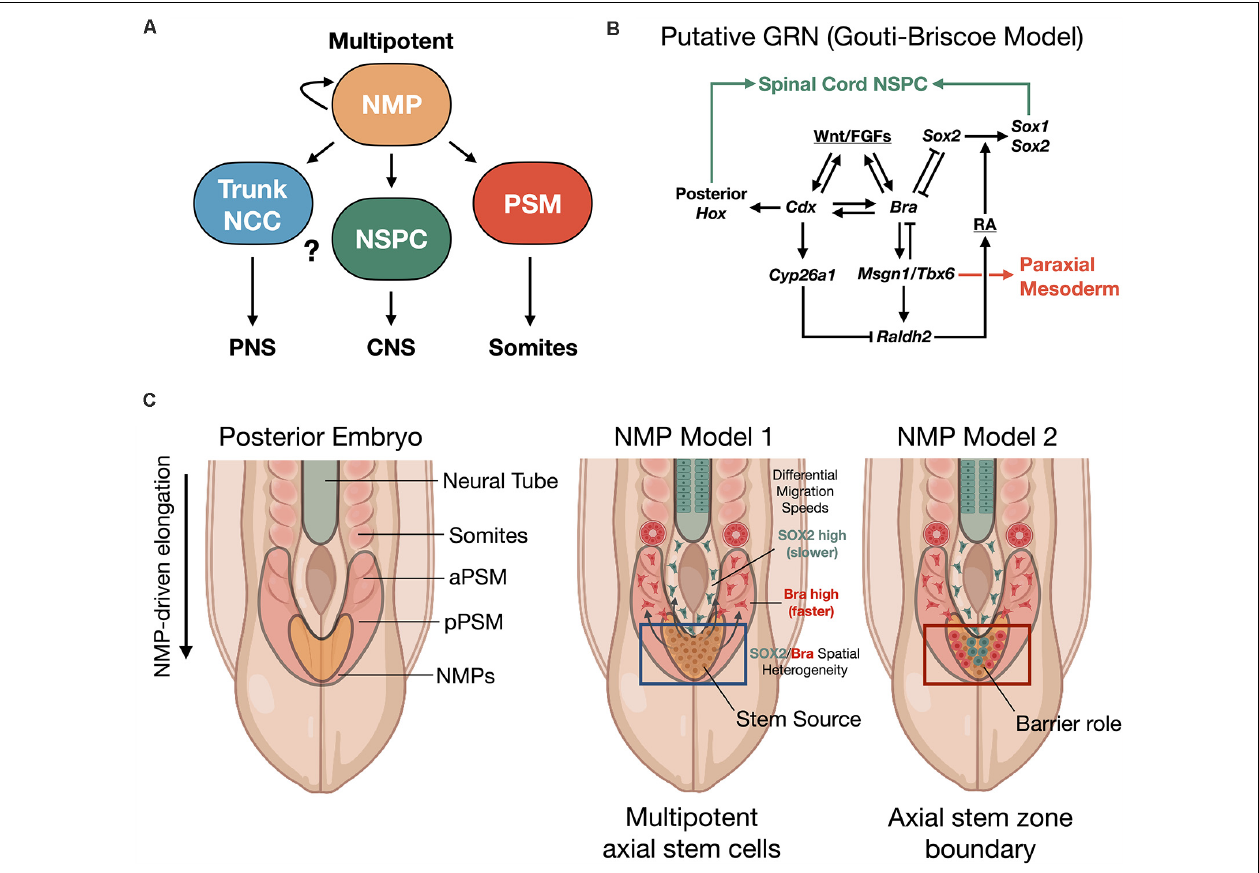
FIGURE 2 | Neuromesodermal progenitor (NMP) models of human trunk and spine development. (A) NMPs act upstream as multipotent building blocks to generate the trunk and spine. (B) Putative gene regulatory network (GRN) of NMP differentiation (Gouti-Briscoe model). RA (retinoic acid), NSPC